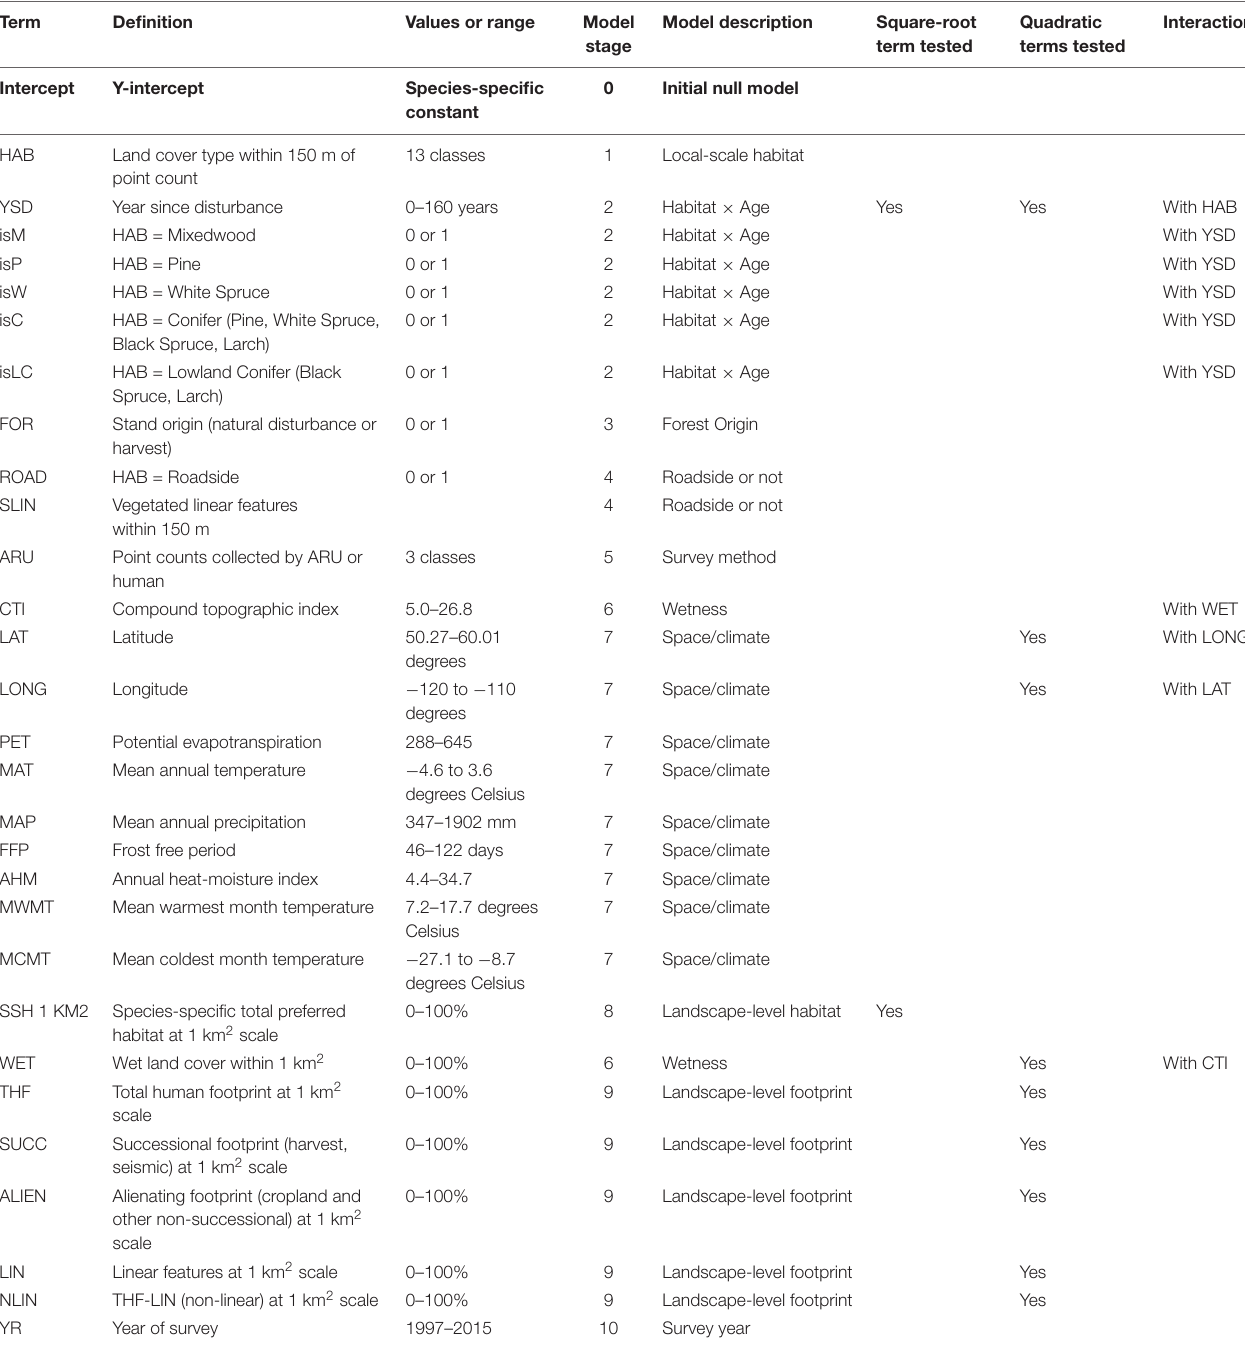
TABLE 1 | Predictors used in the species distribution models to predict density and abundance of each analyzed bird species within individual Forest Management Units and over the Al-Pac Forest Management Area (FMA) over 50 years within the two Patchworks spatial harvest scenarios, the NRV scenario, and the ALCES Online cumulative effects scenarios described in this